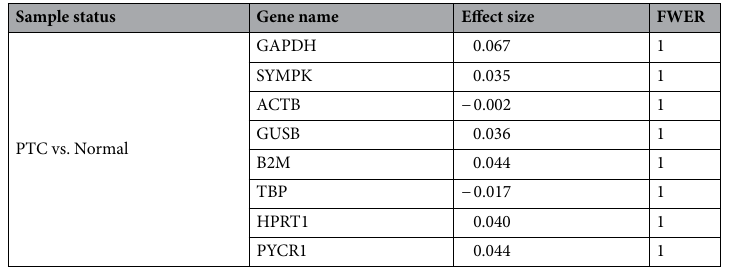
Table 6. TCGA differential expression analysis in PTC samples. PTC samples from the TCGA dataset were analysed for differential expression. ACTB (ES = − 0.002), TBP (ES = -0.017) and SYMPK (ES = 0.035) are the three most stable reference genes in PTC tissues. ES effect size, FWER family-wise error rate.